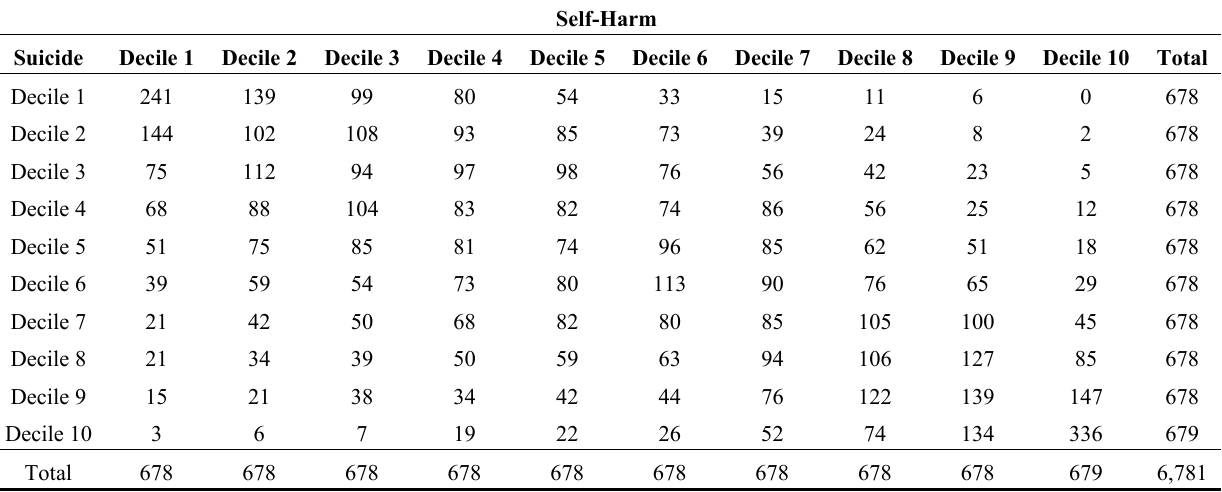
Table 7. Overlap in relative risk deciles (deciles of fitted relative risks, best fitting models).